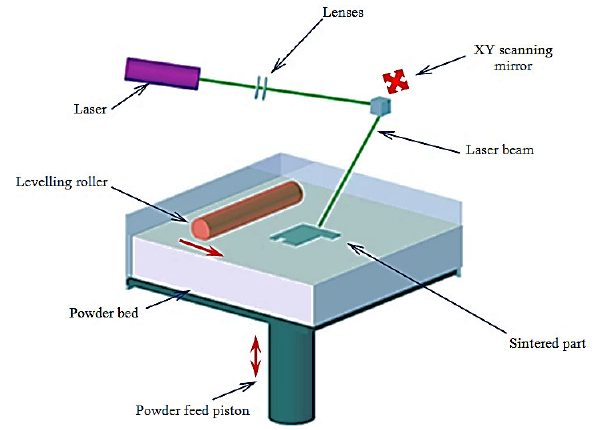
Fig. 11 Schematic diagram showing the powder bed fusion